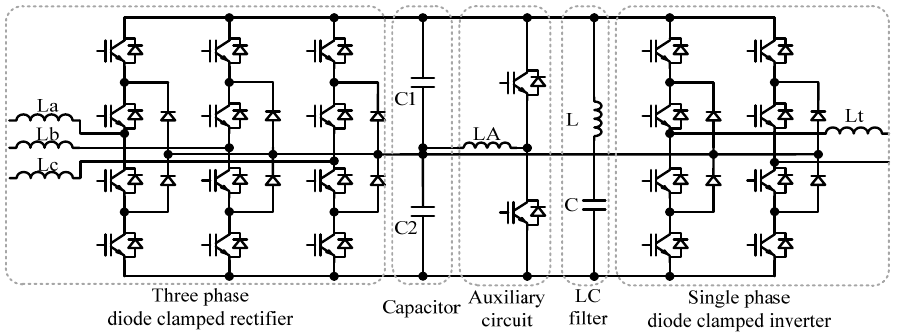
Figure 3. Three-level neutral point clamped (3L-NPC) three-phase to single phase converter with equalizing